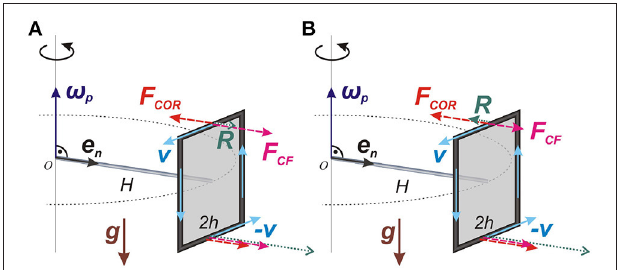
FIGURE 6 | (color online) Relevant forces in the flat square wheel model in the precessing reference frame (bound to the axis of the square wheel). Red broken lines denote the inertial forces acting on the fluid/chain, while green dotted ones the reactive forces acting on the support. (A) Lower flow speed, when the centrifugal force dominates over the Coriolis force, yielding an outward pointing net inertial force. (B) Higher flow speed, when the Coriolis force dominates over the centrifugal force, and an inward pointing net inertial force will result. Notation of forces (see section 2.2 for the nomenclature): F CF - centrifugal, F COR - Coriolis, R - reactive (see section 2.6).